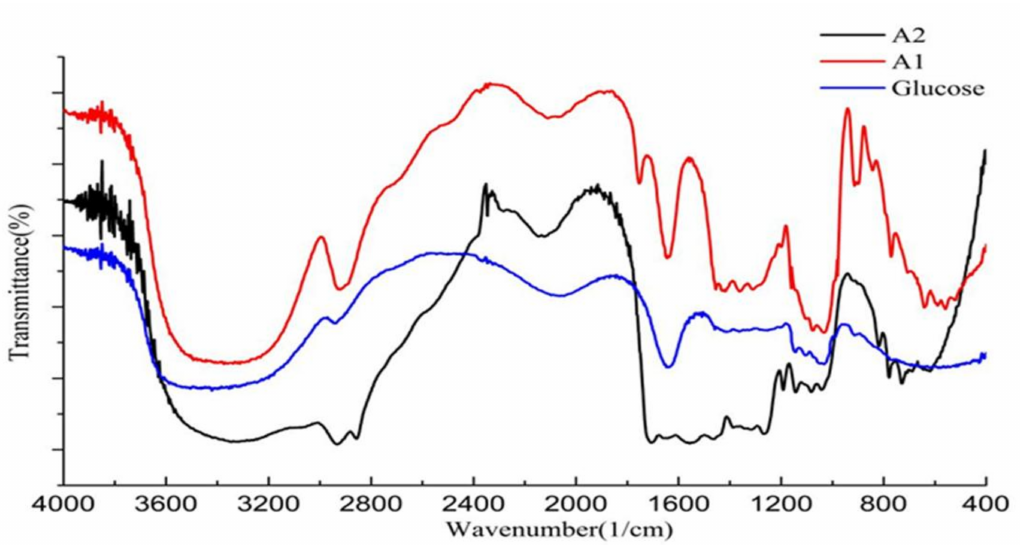
Figure 18. FTIR spectra of glucose, carbonated glucose A1, and glucose-based A2 NIPU resin.